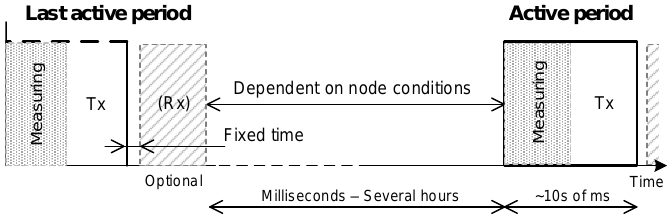
Figure 2. treNch principle of operation.